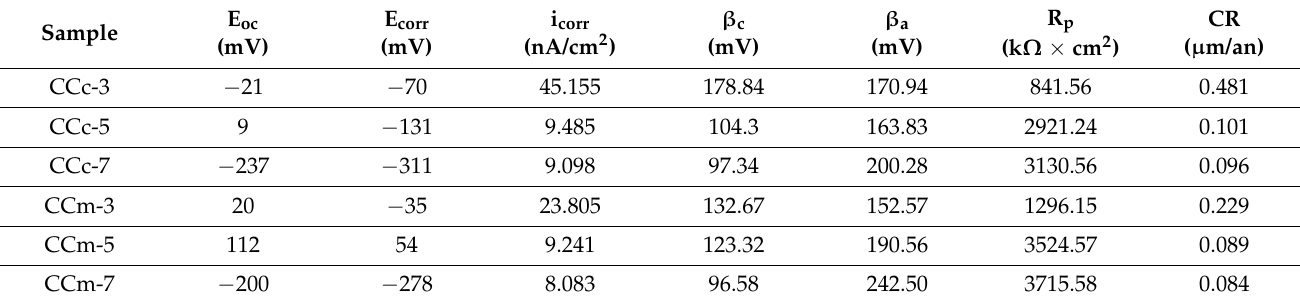
Figure 10. Tafel plots of milled Co-Cr alloy in all testing media. The main electrochemical parameters extracted using Tafel extrapolation are presented in Table 5. Table 5. The main electrochemical parameters of the investigated